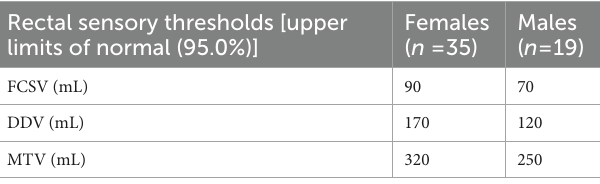
TABLE 1 Rectal sensory thresholds (mLs) in 54 healthy individuals (35 women) by